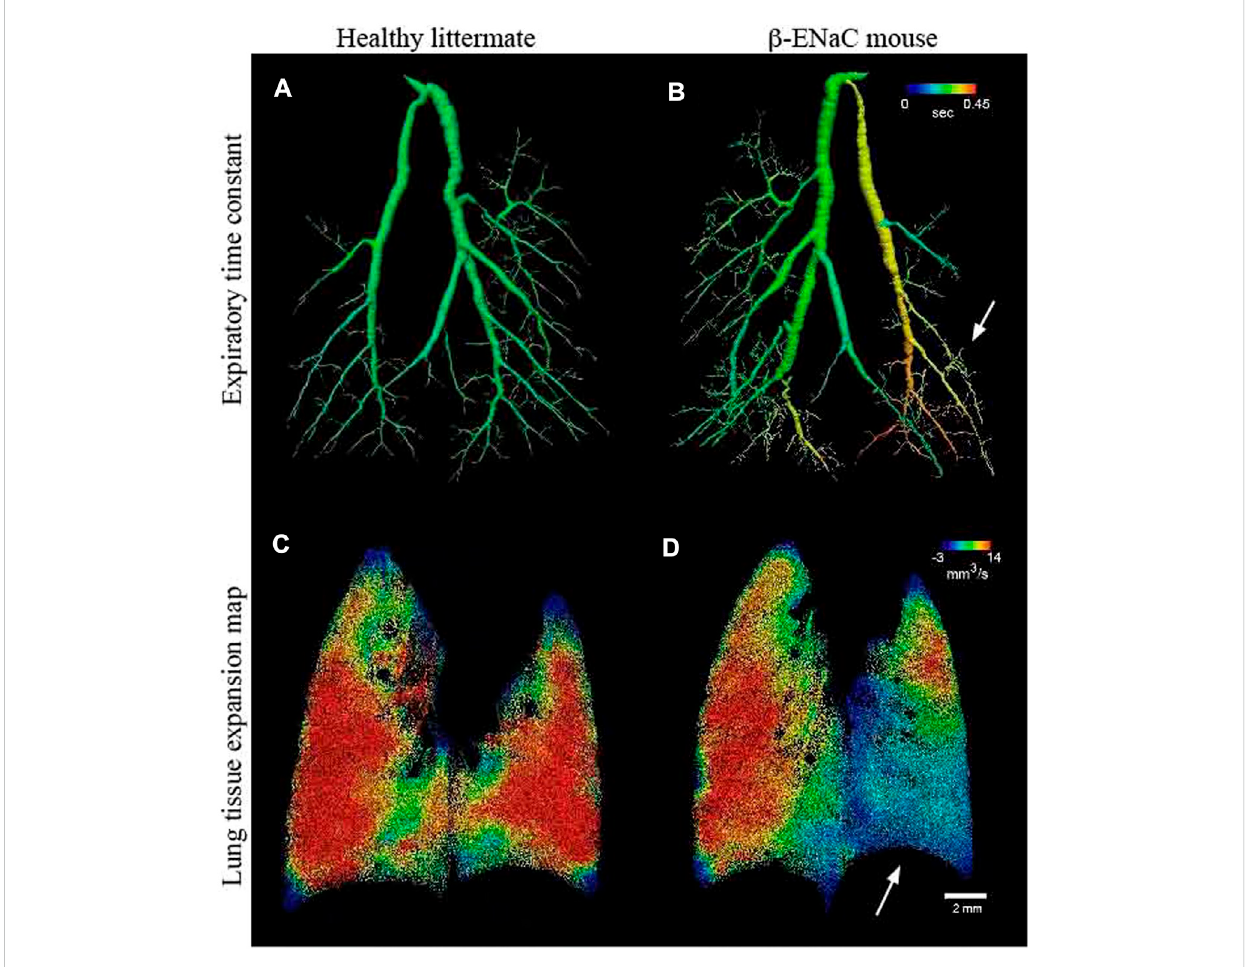
FIGURE 9 Lungfunctionassessments using4DxVtechnique [reprintedfromMurrieetal. (Murrieetal.,2020)] (A,B) Airway3Dmodelsofahealthyand β -ENaC mice, respectively, colored by local expiratory time constant from 4DxV analysis showing an increased expiratory time constant (arrow) for the β -ENaC mousecomparedtothehealthylittermate; (C,D) Comparisonofthelungtissueexpantionmapsofthehealthyand β -ENaCmice,respectively,revealinga reduction in regional tissue expansion (arrow) for the β -ENaC mouse compared to the healthy